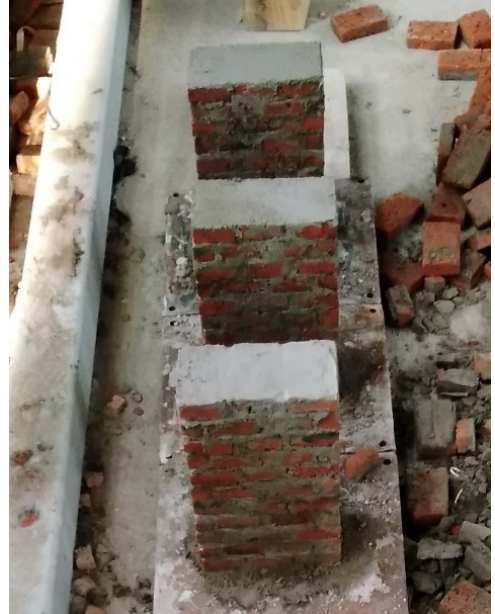
Figure 8. Masonry specimens.